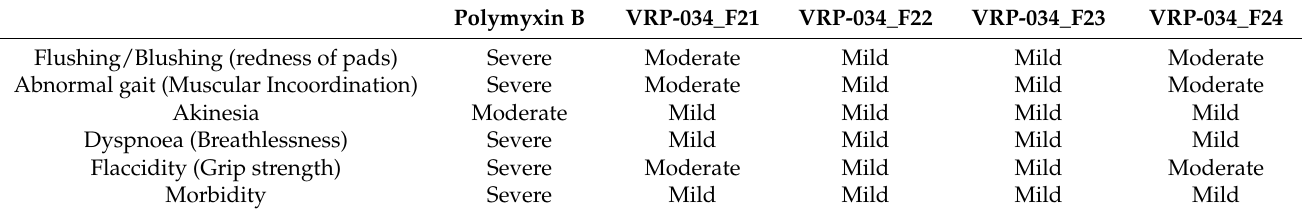
Table 2. Clinical observations in the polymyxin B (control) and novel formulation groups